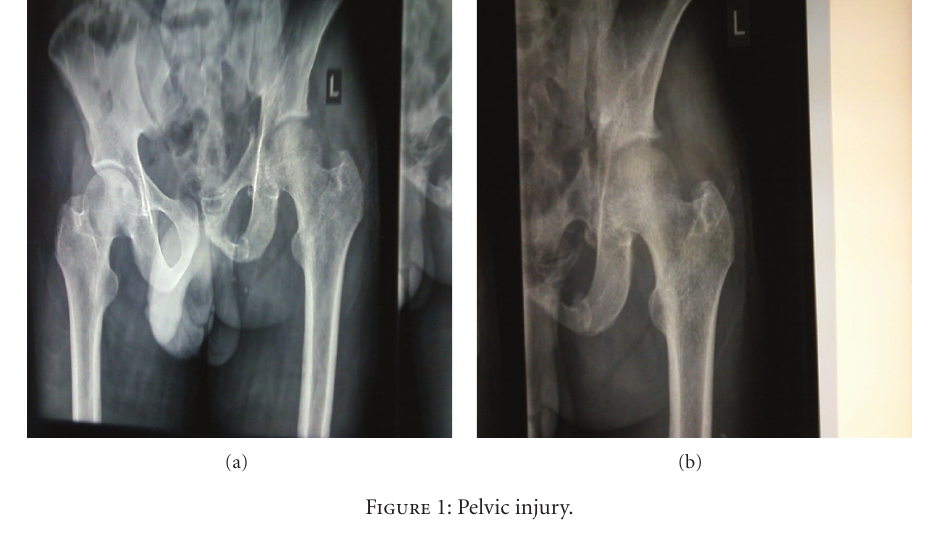
Figure 1: Pelvic injury.